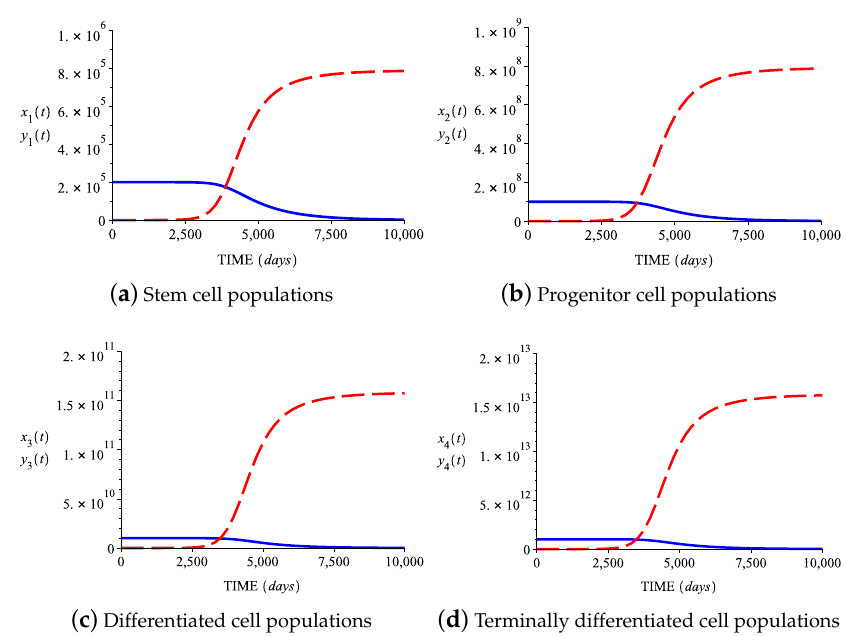
Figure 7. Behavior of ( a ) stem cell populations, ( b ) progenitor cell populations, ( c ) differentiated cell populations, and ( d ) terminally differentiated cell populations for the parameter values: a 1 = 0.005, a 2 = 4, a 3 = 5, a 4 = 100, b 1 = 0.75 × 10 − 5 , b 2 = 0.38 × 10 − 5 , c 1 = 0.002, c 2 = 0.008, c 3 = 0.05, c 4 = 1, A 1 = 0.01, A 2 = 8, A 3 = 10, A 4 = 100, B = 0.19 × 10 − 5 , C 1 = 0.004, C 2 = c 2 , C 3 = c 3 , C 4 = c 4 , and initial conditions: x 1 ( 0 ) = 2 × 10 5 , x 2 ( 0 ) = 1 × 10 8 , x 3 ( 0 ) = 1 × 10 10 , x 4 ( 0 ) = 1 × 10 12 , y 1 ( 0 ) = y 2 ( 0 ) = y 3 ( 0 ) = y 4 ( 0 ) =